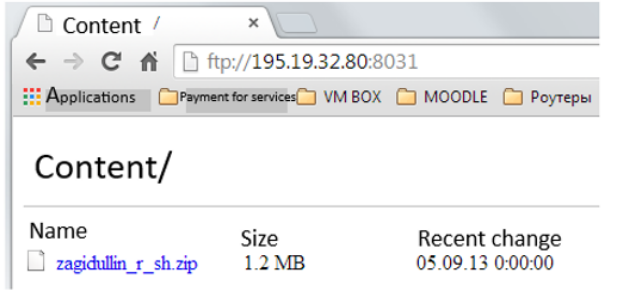
Fig. 8 . Access to the data repository of the laboratory practical work in the